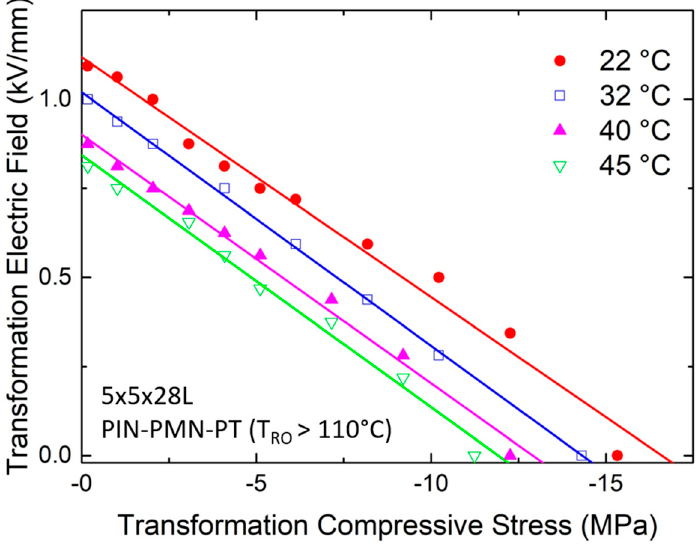
Figure 5. Transformation curves of square-pipe stake actuators made of Pb(In 0.5 Nb 0.5 )O 3 -Pb(Mg 1/3 Nb 2/3 )O 3 - PbTiO 3 (PIN-PMN-PT) single crystals.